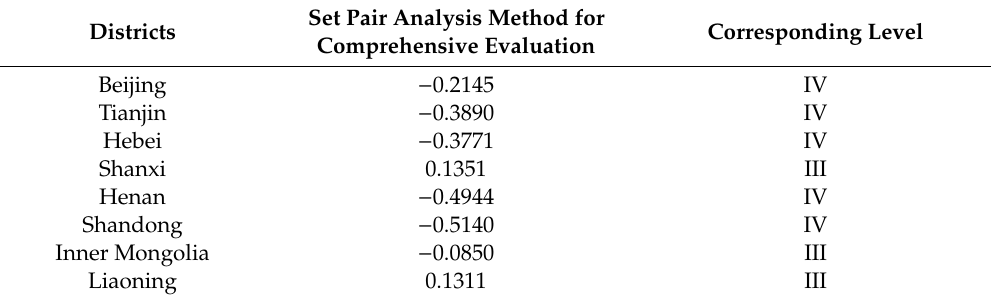
Table 5. Annual AWRCC set pair analysis results of the Haihe district provinces and cities. Set Pair Analysis Method for Corresponding Level Districts Comprehensive Evaluation Beijing − 0.2145 IV Tianjin − 0.3890 IV Hebei − 0.3771 IV Shanxi 0.1351 III Henan − 0.4944 IV Shandong − 0.5140 IV Inner Mongolia − 0.0850 III Liaoning 0.1311 III